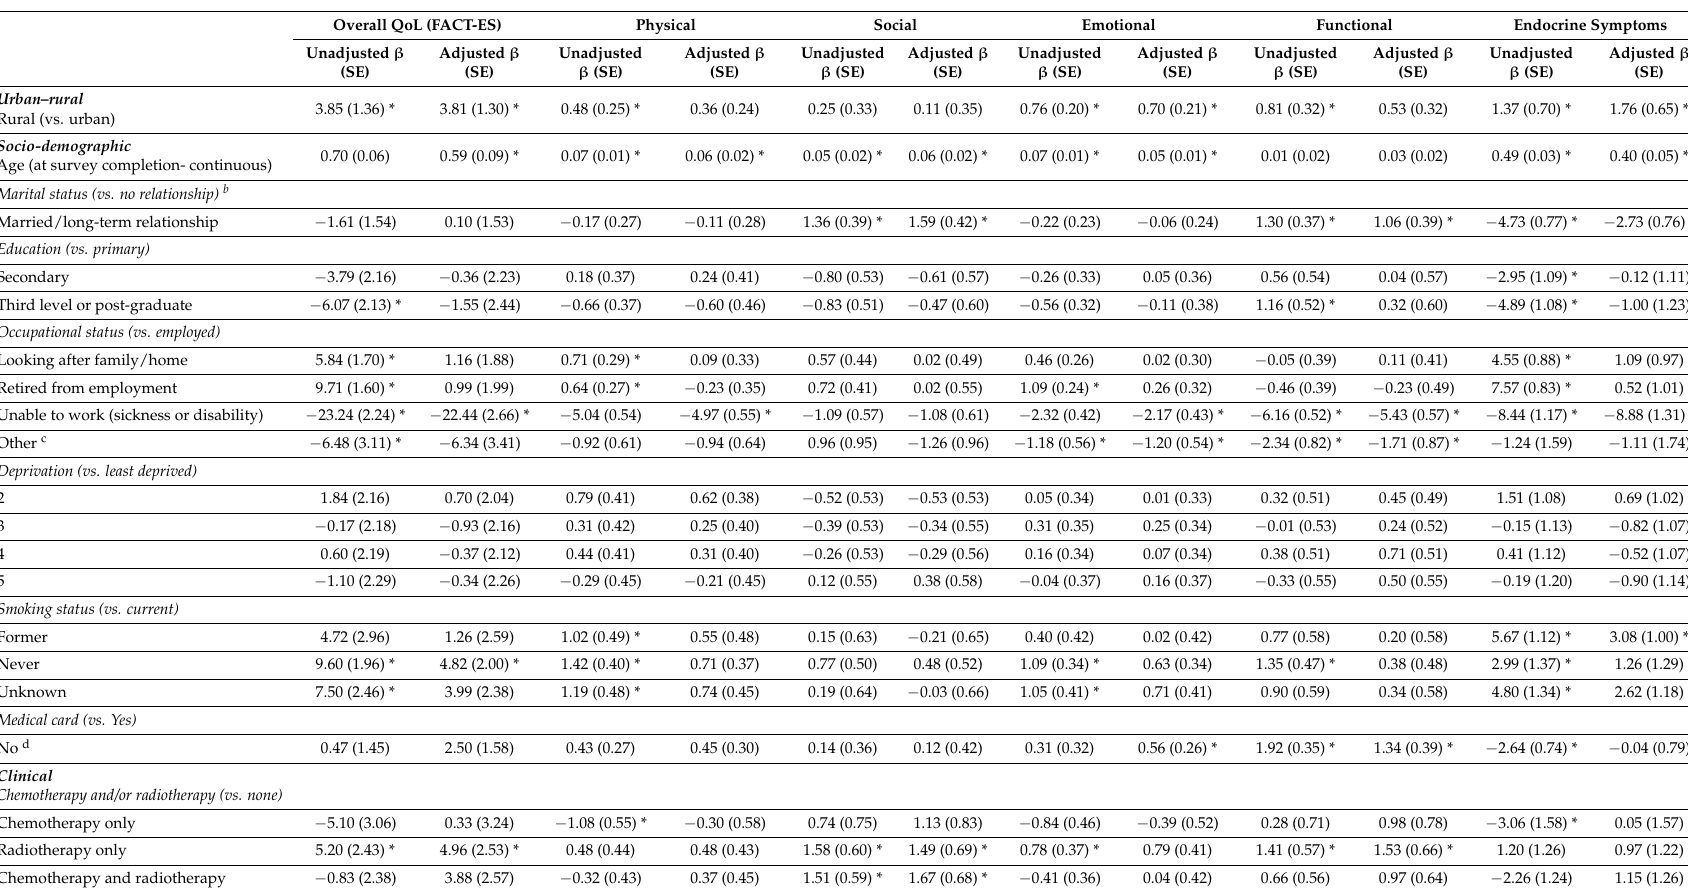
Table 3. Unadjusted and adjusted coefficients (SE) for FACT-ES, individual domains and endocrine symptoms by urban–rural, socio-demographic and clinical factors a